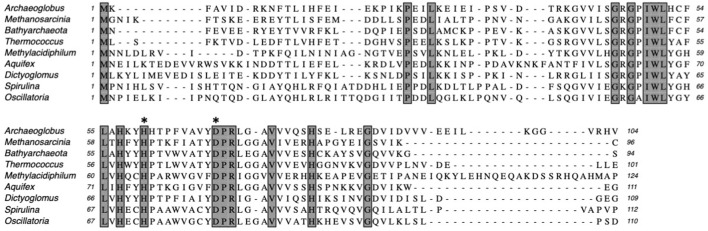
Multiple sequence alignment of Csx3 proteins showing conserved residues.Csx3 proteins are shown from Archaeoglobus fulgidus; Methanosarcinia mazei; Candidatus Bathyarchaeota; Thermococcus celericrescens; Methylacidiphilum fumariolicum; Aquifex aeolicus; Dictyoglomus turgidum; Spirulina major; Oscillatoria nigro-viridis. Absolutely conserved residues are shaded. Conserved residues H60 and D69 (Afu numbering) are indicated by asterisks.